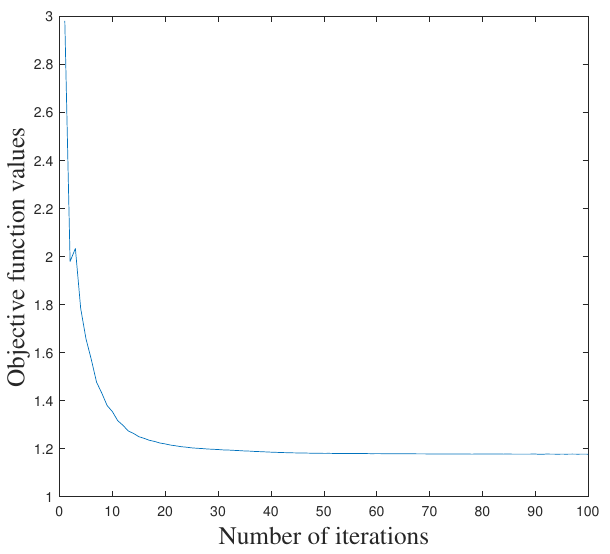
Figure 1. The convergence curve of the proposed LPLC-HDL with the number of iterations on the Yale face